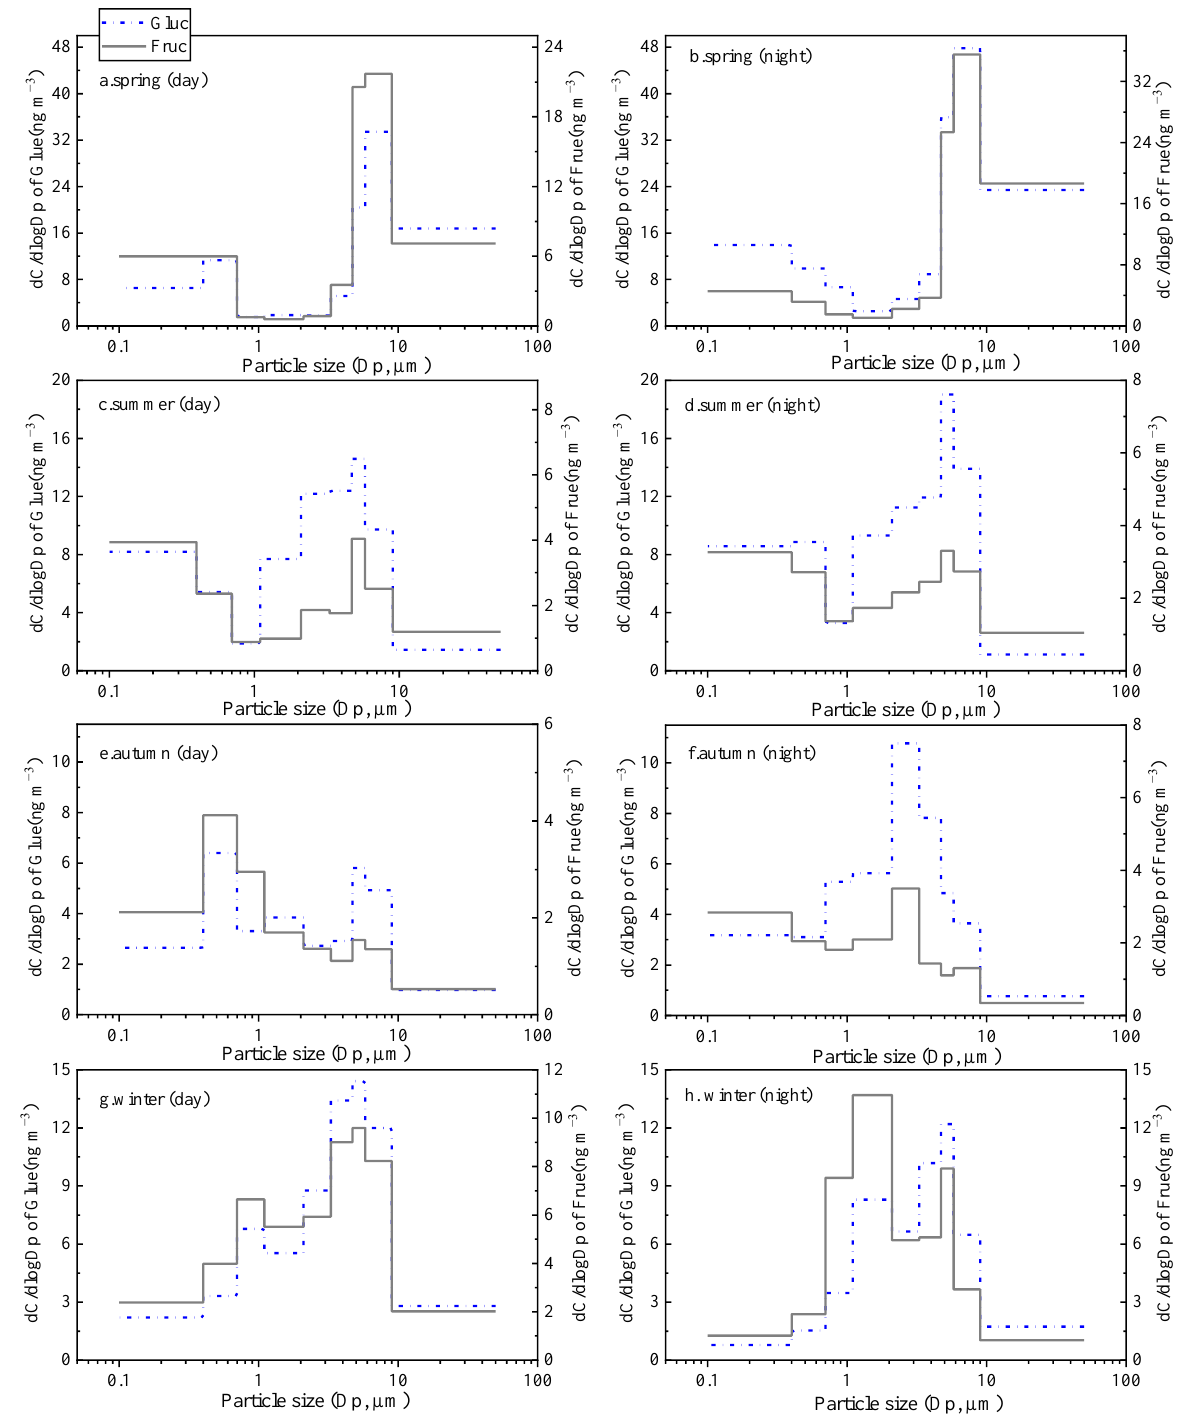
Figure 6. Seasonal particle size distributions of glucose (Gluc) and fructose (Fruc) ( a ). spring day; ( b ).spring night; ( c ). summer day; ( d ). summer night; ( e ). autumn day; ( f ). autumn night; ( g ). win- ter day; ( h ). winter night.